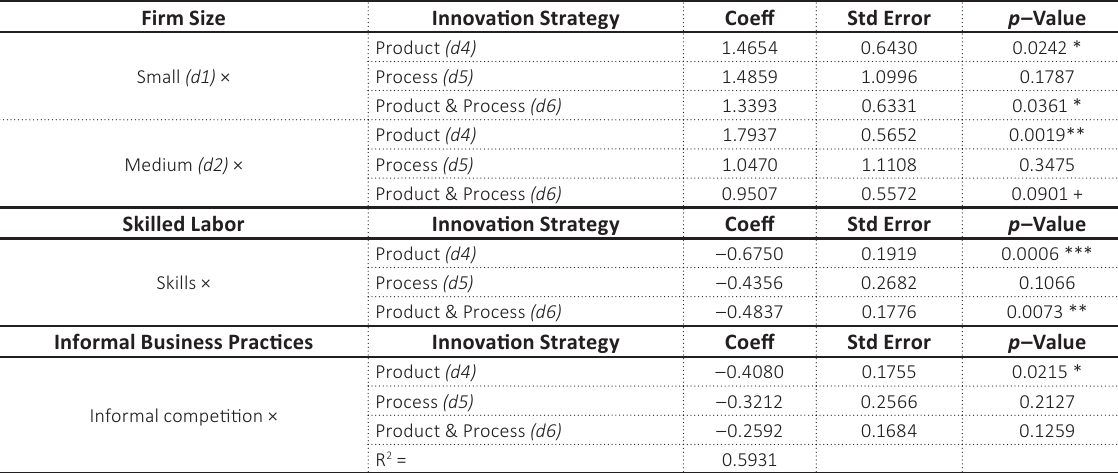
Table 6. Innovation strategy interaction’s effect on R&D costs